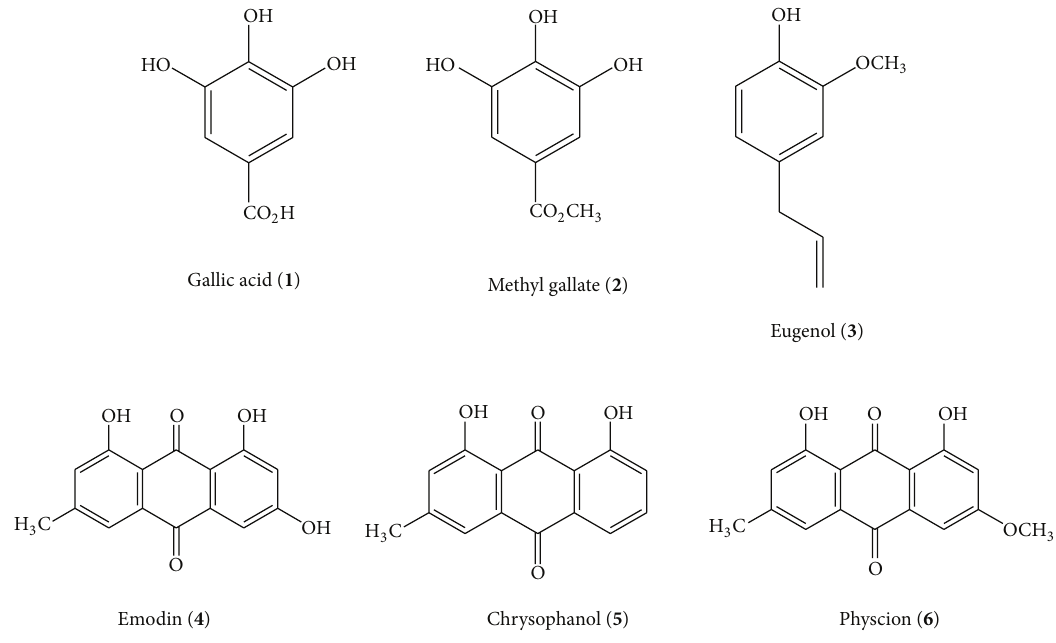
Figure 1: Chemical structures of the indicator compounds 1 – 6